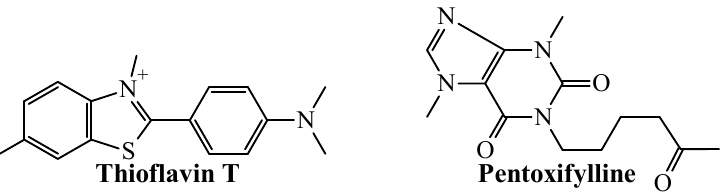
Figure 4. Chemicals correctly classified by the mtc-QSAR-MLP model as TNF-alpha inhibitors. The predictions performed by the mtc-QSAR-MLP model for all the aforementioned inhibitors can be found in Table 4. Table 4. Different drugs or drug-derived chemicals correctly predicted by the mtc-QSAR-MLP model as protein inhibitors according to their experimental IC 50 values reported in the ChEMBL database.